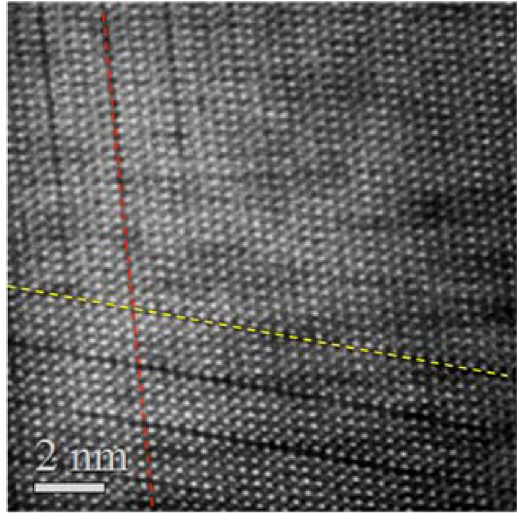
Figure 7. HAADF STEM micrograph of a sputtered sample, annealed at 315 °C, exhibiting rocksalt structure and ordered vacancy layers on two different {111} planes, indicated with red and yellow dashed